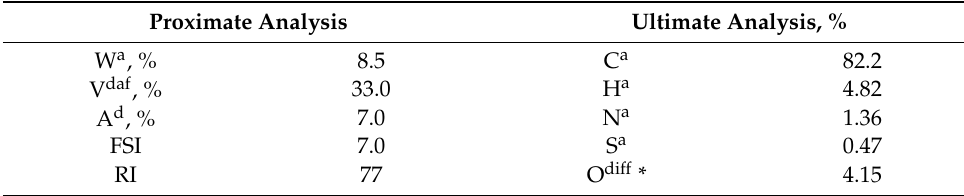
Table 1. The characteristics of studied